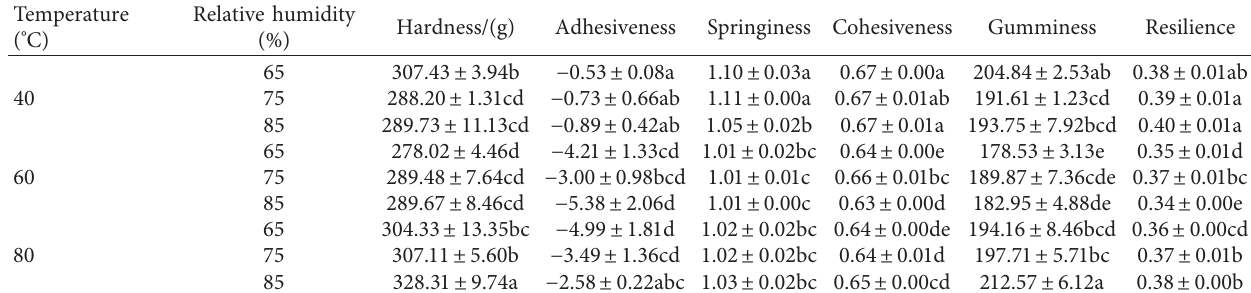
Table 4: Effects of drying temperature and relative humidity on TPA of cooked